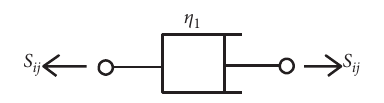
Figure 4: 3D viscous fatigue element.